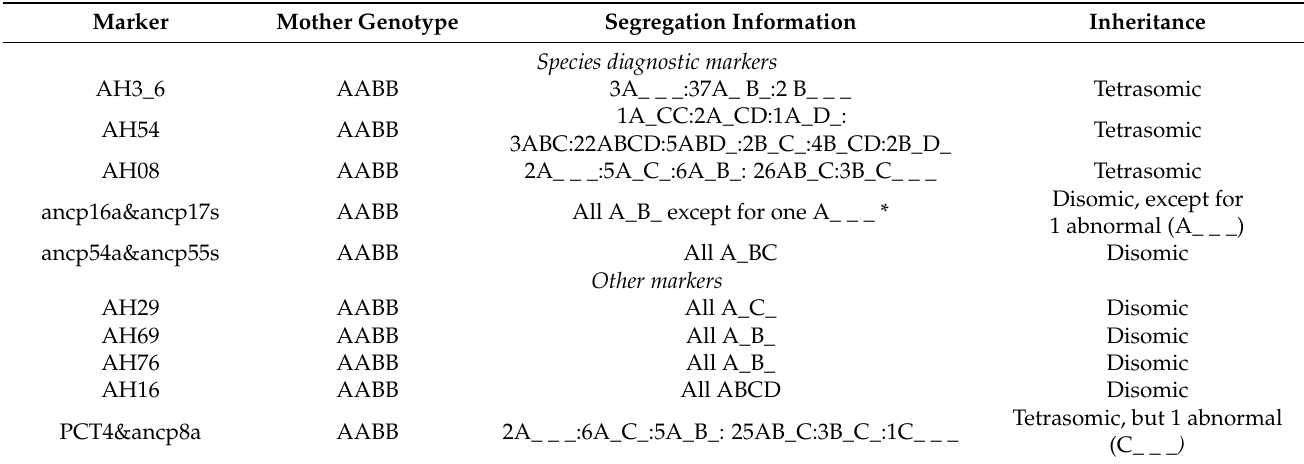
Table 7. Summary of inheritance pattern for 15 SSR loci in outcross progenies (n = 42) of allotetraploid (4 x ) acacia hybrid.